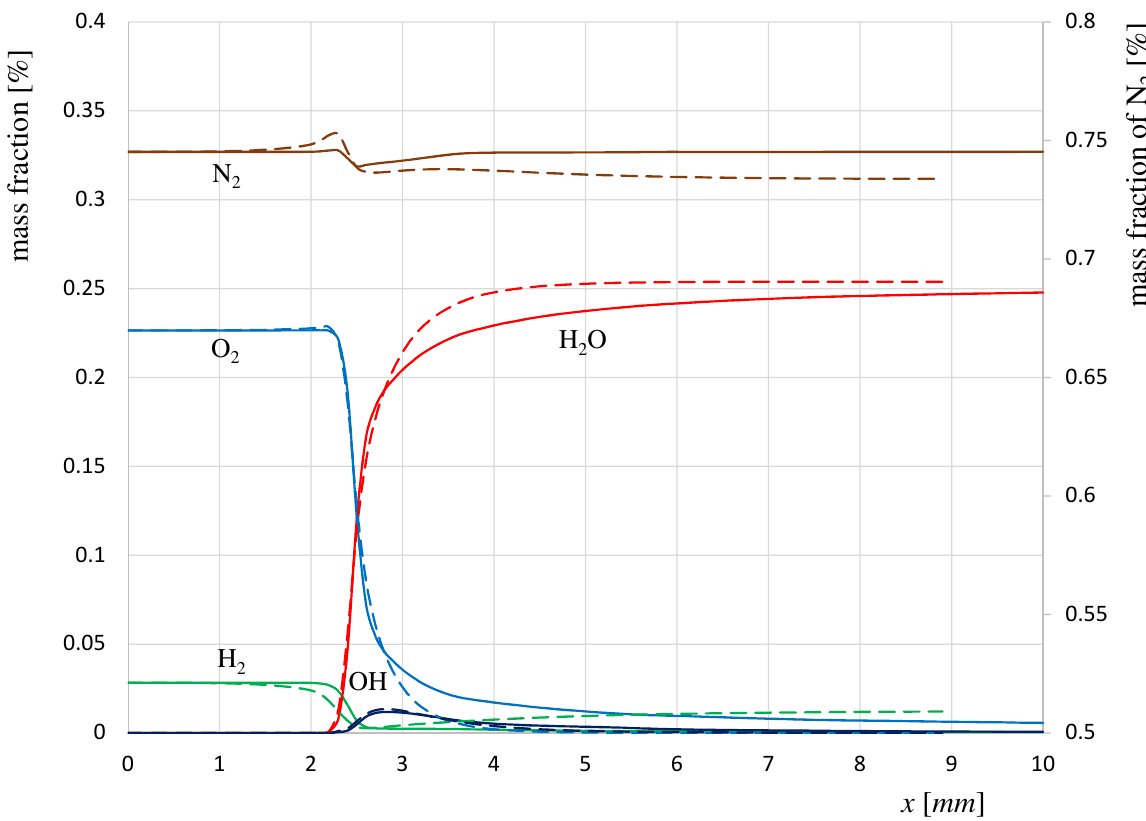
Figure 10. Comparison between the cases CH1 (continuum lines) and R1 (dashed lines) of the main species mass fractions in axial direction along the